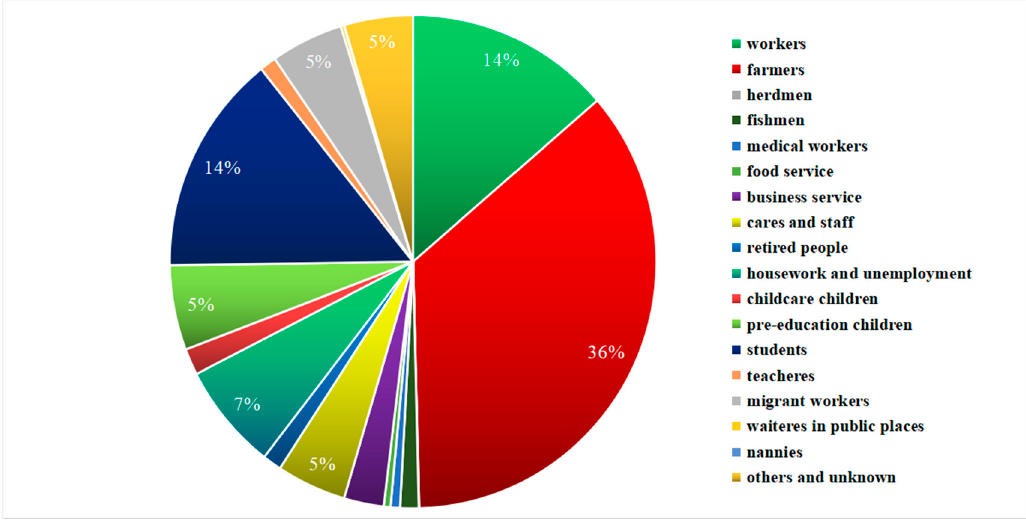
Figure 8. Occupational distribution of typhoid and paratyphoid in Zhejiang from 1991 to 2014.